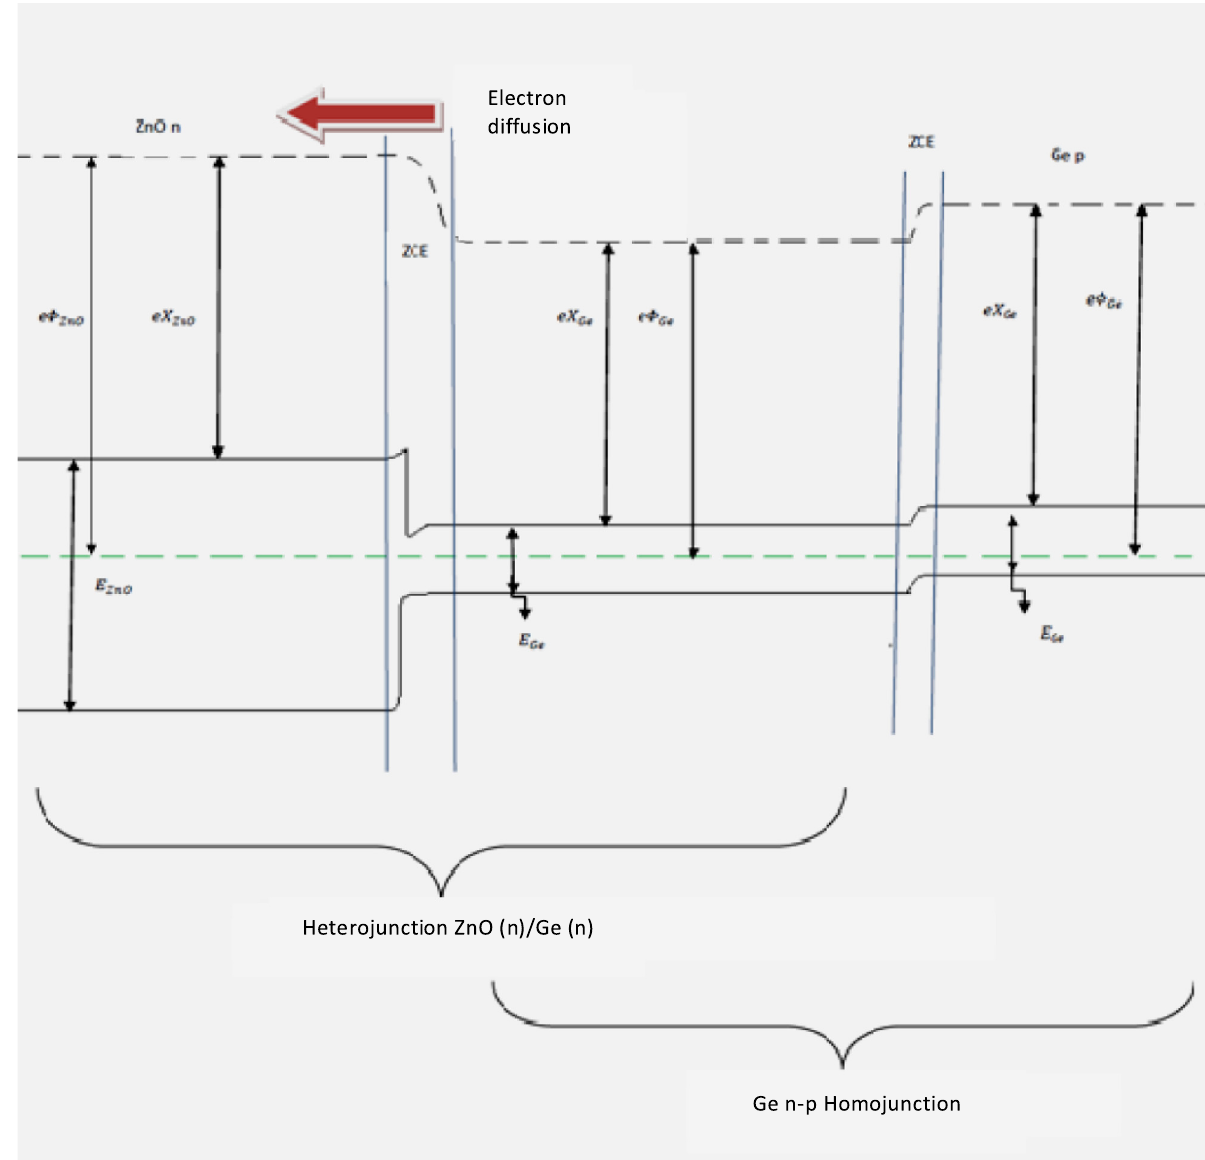
Fig. 7. Energy band diagram of the entire ZnO/Ge